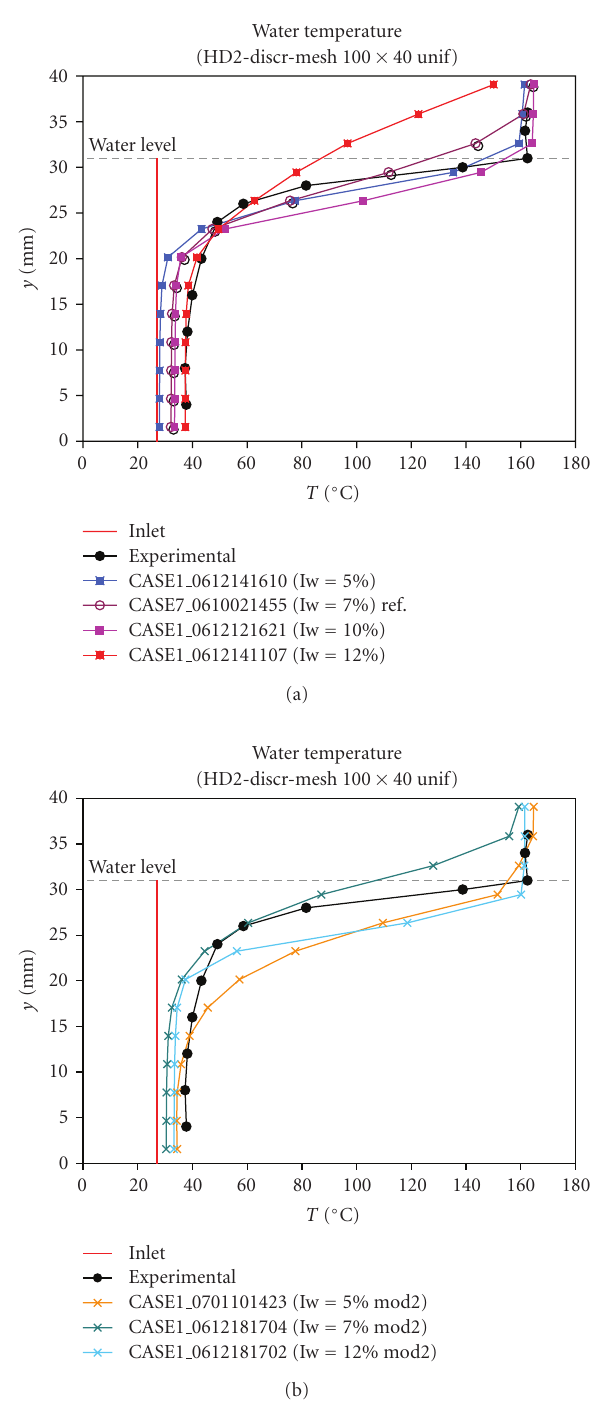
Figure 10: Water temperature profiles: inlet turbulence sensitivity study.